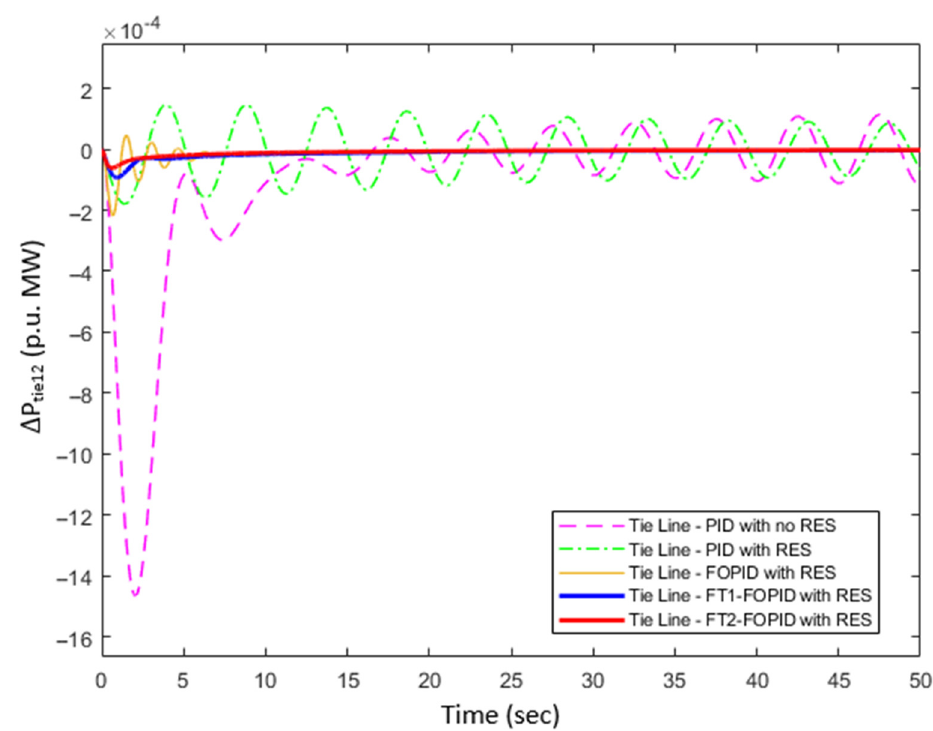
Figure 13. Results for 1% load alteration in tie-line. Table 5. ITAE results obtained for various controllers for demand change of 1% in Area 1 and 2% in Area 2. F 1